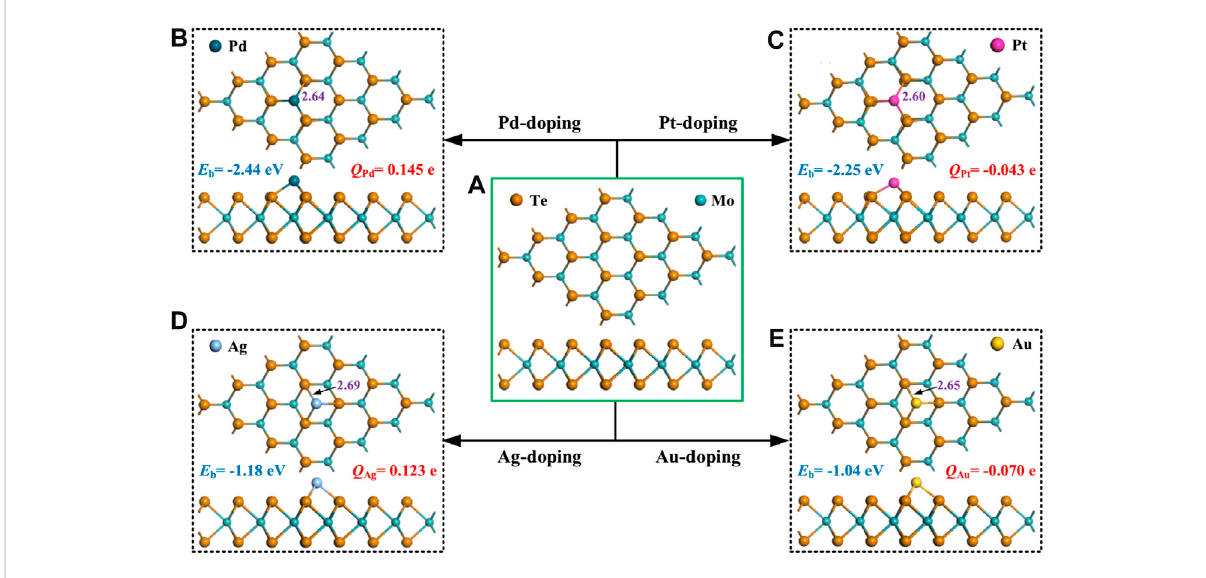
FIGURE 2 MSC of (A) pristine, (B) Pd-doped, (C) Pt-doped, (D) Ag-doped and (E) Au-doped MoTe 2 monolayer. The violet values are bond lengths of TM- Te, unit in